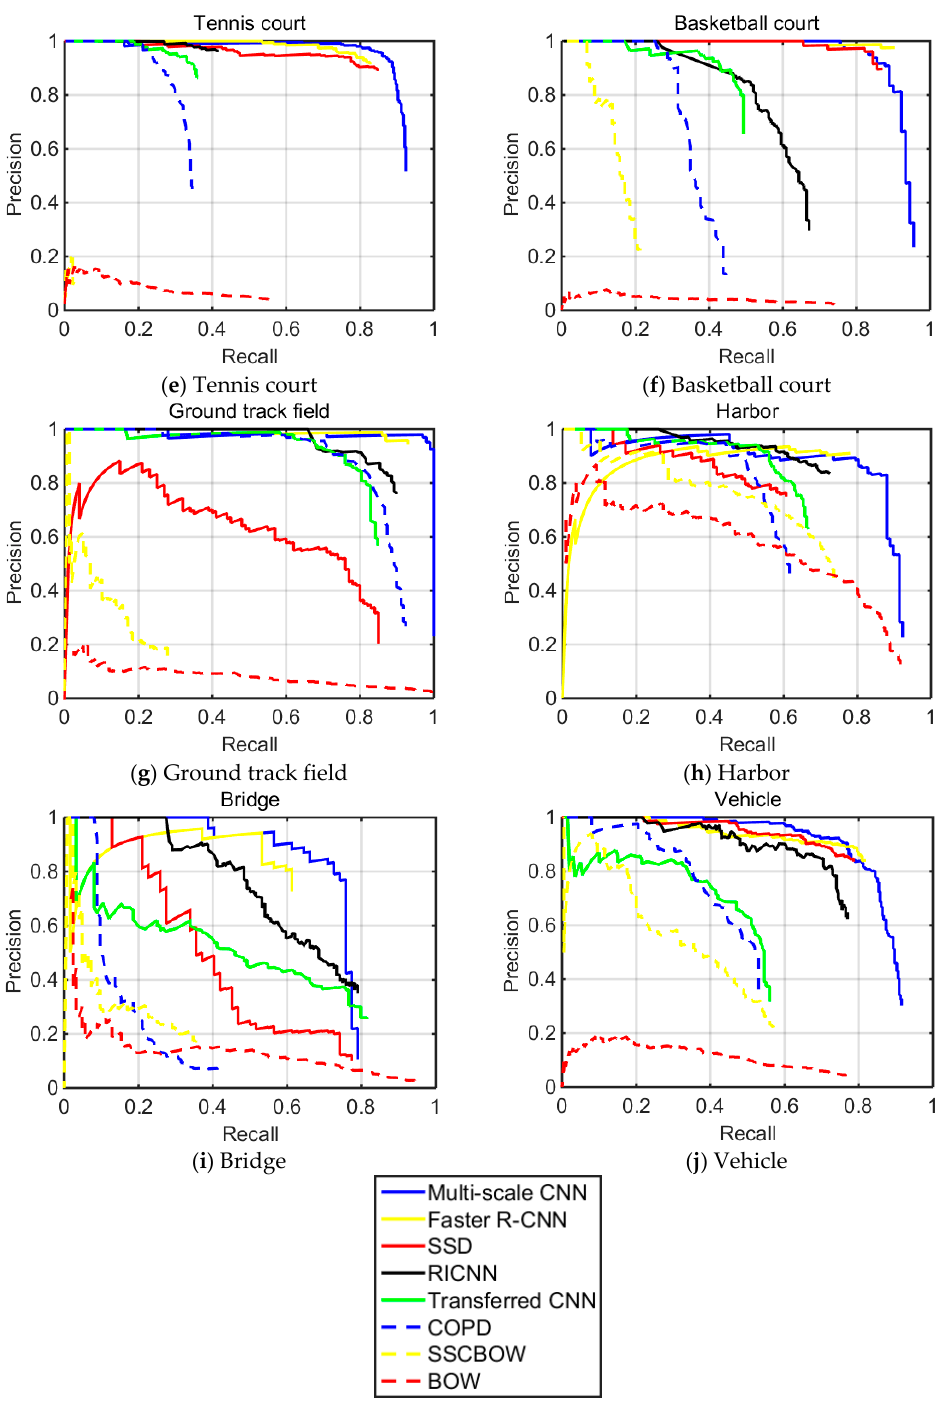
Figure 9. Precision versus recall curve for each method.